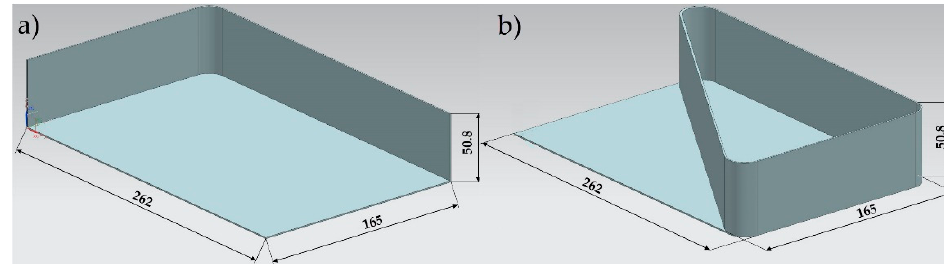
Figure 3. Thin-walled samples: ( a ) with a semi-open structure and ( b ) with a closed structure. The cutting was performed on the Avia VMC 800HS vertical machining centre with high performance cutting and high speed cutting functions. With the aim of applying high speed cutting on aluminium alloys belonging to the ISO N material group, the